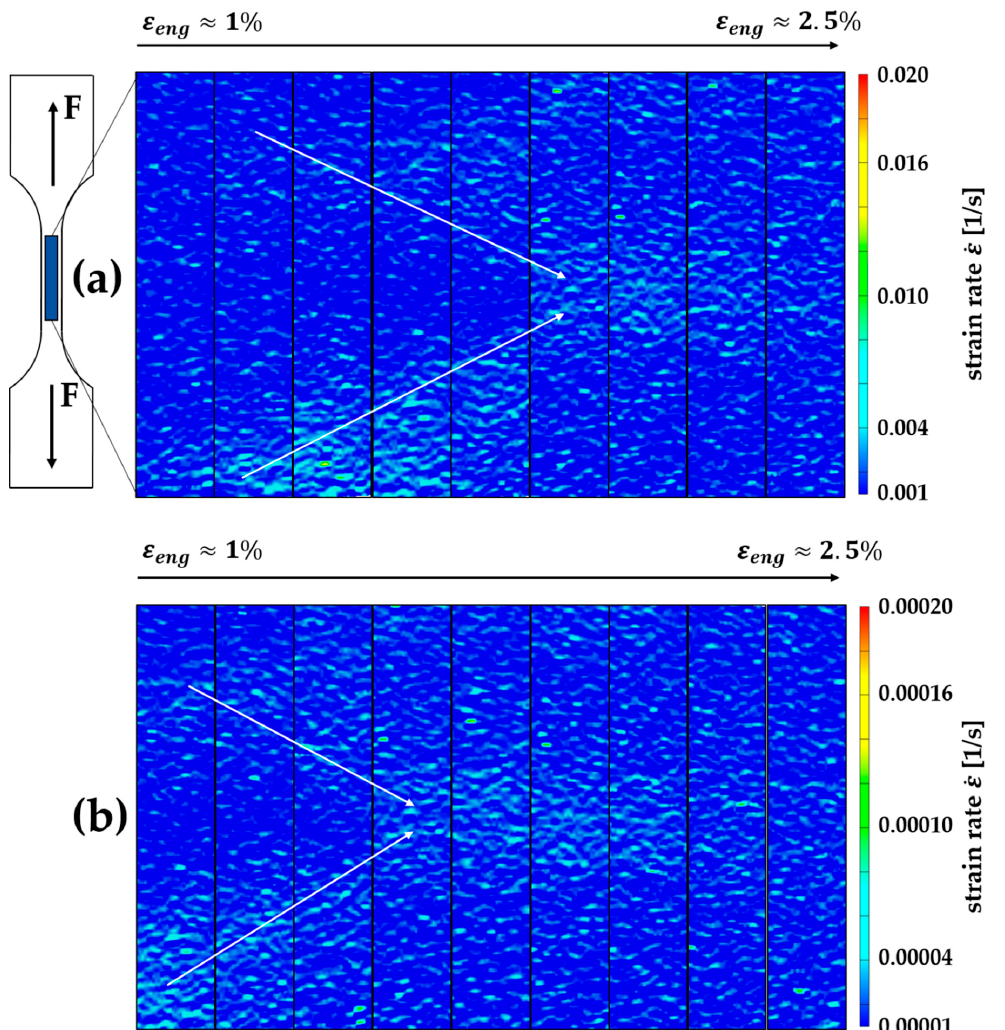
Figure 10. Visualization of local strain rate distribution in a tensile test sample during the discontinuous elastic-plastic transition using in-situ DIC during tensile testing at ( a ) 0.001 1/s and ( b ) 0.00001 1/s. White arrows highlight the propagation of localized peaks in strain rate during straining.